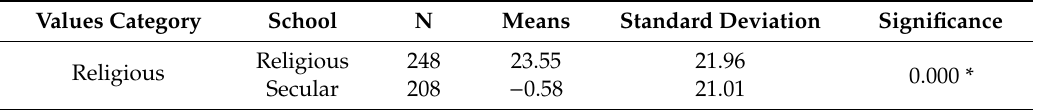
Table 4. One-way analysis of variance of the religious values category according to the school variable. Values